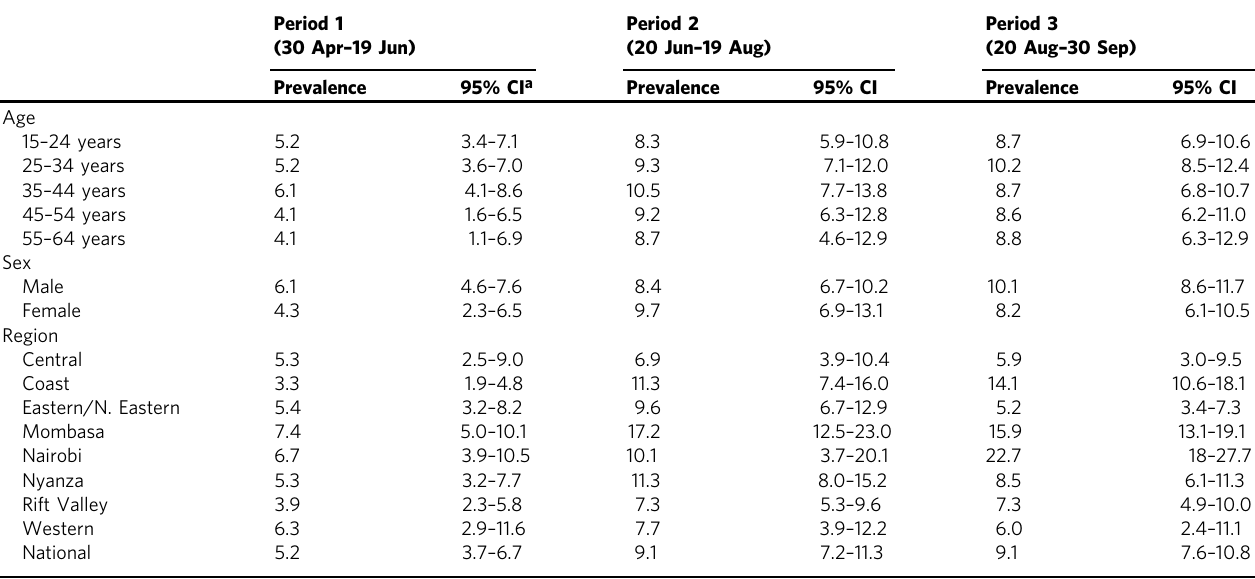
Table 2 Bayesian-weighted test-adjusted SARS-CoV-2 anti-spike protein IgG seroprevalence across three study